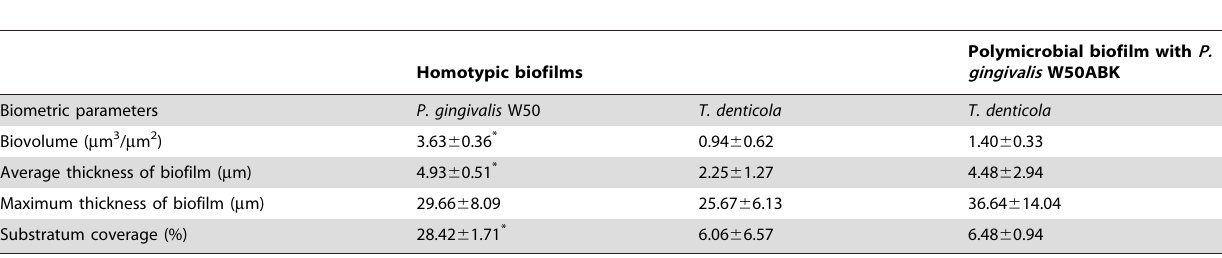
Table 1. Biometric parameters of P. gingivalis and T. denticola homotypic biofilm and polymicrobial biofilm formed by P. gingivalis W50 ABK, T. denticola and T. forsythia harvested at 90 h.